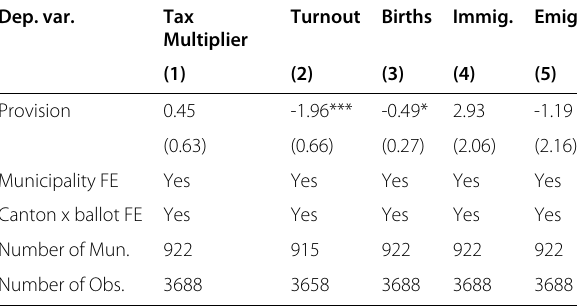
Table 10 DiD estimates of the introduction of lunchtime and trends